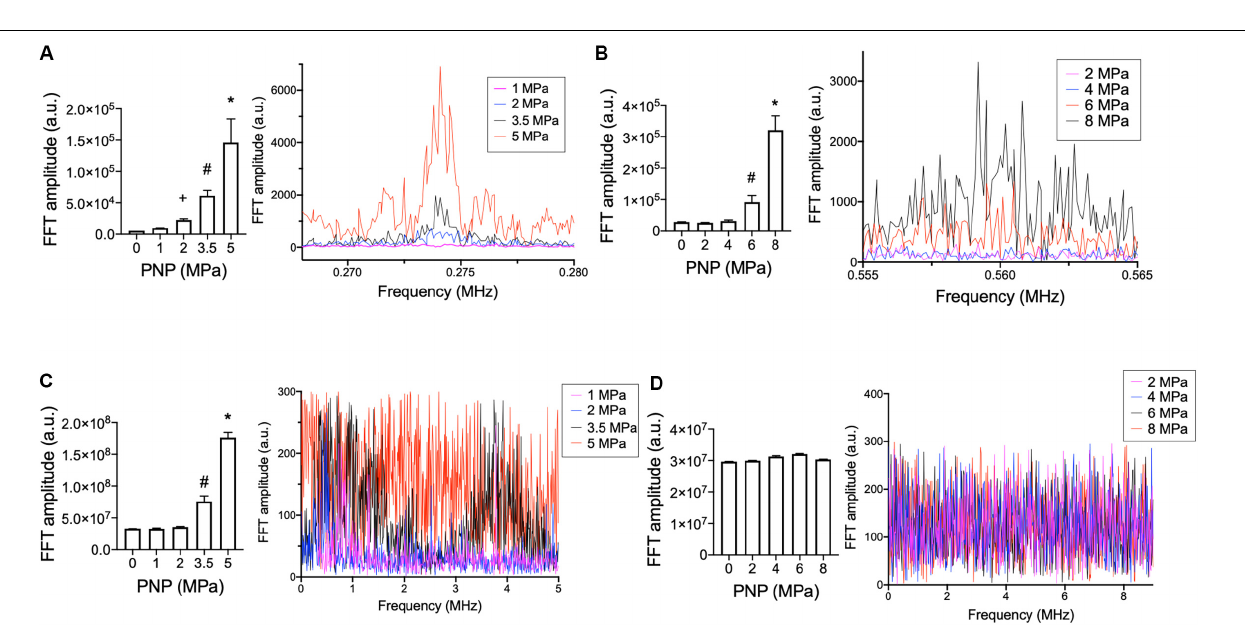
FIGURE 2 | Prostaglandin production in skeletal muscle following sonication at different intensities and frequencies. Mouse hamstrings ( n = 6 per treatment group) were sonicated at 0.5 or 1.15 MHz and relative expression of PGH 2 (A,C,E) and PGE 2 (B,D,F) at 6 h post-sonication are shown. Changes in prostaglandins for each frequency were then plotted as functions PNP (A,B) , ARF (C,D) , and MI (E,F) . Significantly elevated prostaglandin levels ( p < 0.05 by ANOVA) compared to sham sonication levels are indicated by open symbols while filled symbols indicate statistically similar values. Each curve was fit using quadratic equations and statistical comparisons between curves were performed by extra sum of squares F tests. Curves compared between frequencies in panels (E) and (F) were found to be significantly similar ( p values shown) and thus data are presented with single curve fits for data sets from both frequencies.